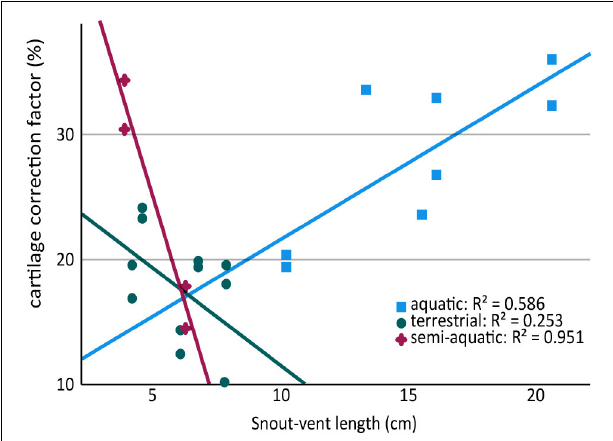
FIGURE 4 | Scatter plot showing relationship between snout-vent length (SVL) and cartilage thickness in the humerus and femur of aquatic, semi-aquatic, and terrestrial salamanders. There is a positive relationship between cartilage thickness and SVL in aquatic salamanders and a negative relationship in semi-aquatic and terrestrial salamanders. Note that there are two data points per specimen (humerus and